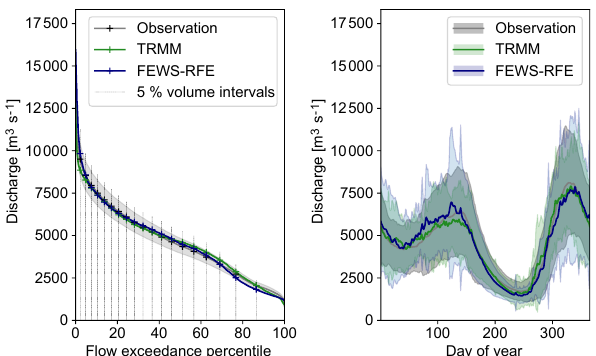
Figure 8. Flow duration curves and daily discharge climatology benchmark at the Lambaréné calibration stations; the surfaces in the climatology plot represent the 90% confidence